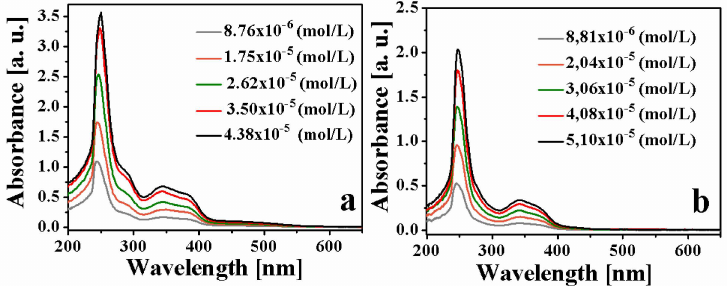
Figure 1. UV–VIS spectra of: ( a ) 2b and ( b ) 4b aminocarbene complexes in CHCl 3